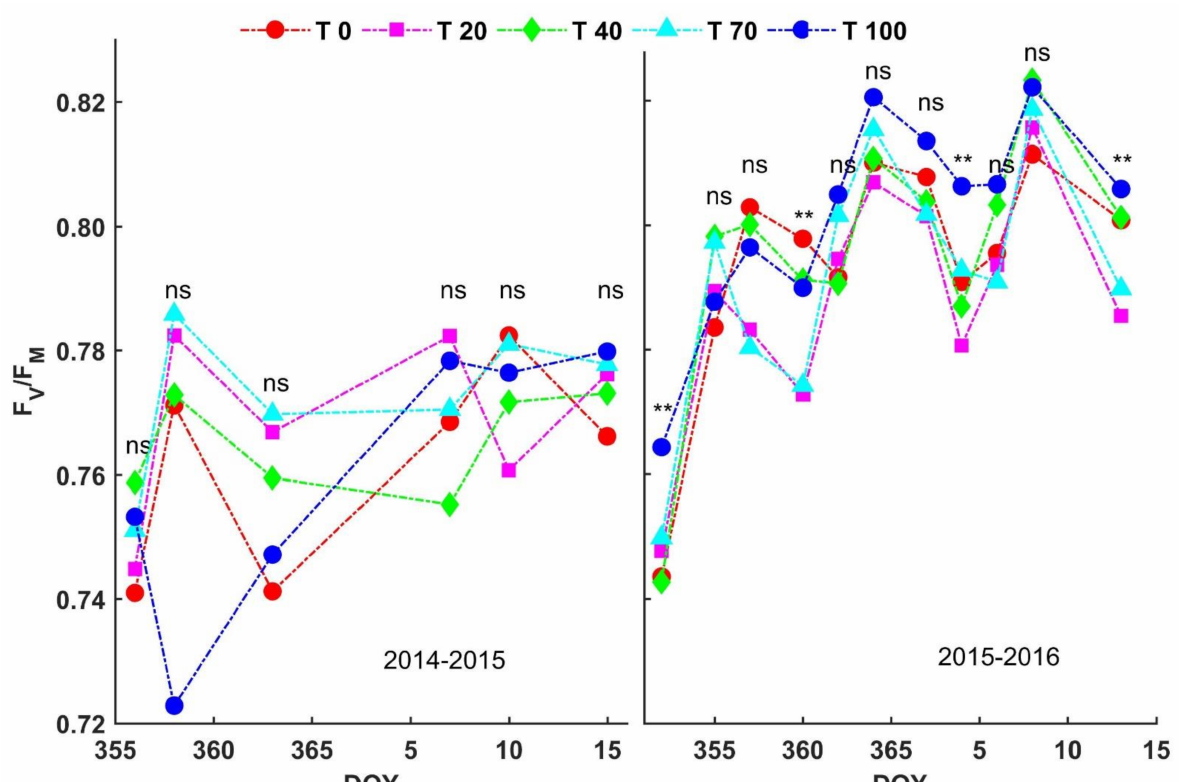
Figure 5. Maximum quantum yield (FV/FM) under five irrigation treatments (T): T0, T20, T40, T70, and T100 in 2014/2015 and 2015/2016 seasons. Each point represents the average of 16 measurements (4 quinoa genotypes and 4 replicates each). T and 0, 20, 40, 70, and 100 represent the levels of available water to the plant in a 0.6 m deep root zone just before irrigation. DOY is the day of year. **, measurement date indicating that significant differences were found. ns, measurement date indicating that no significant differences were